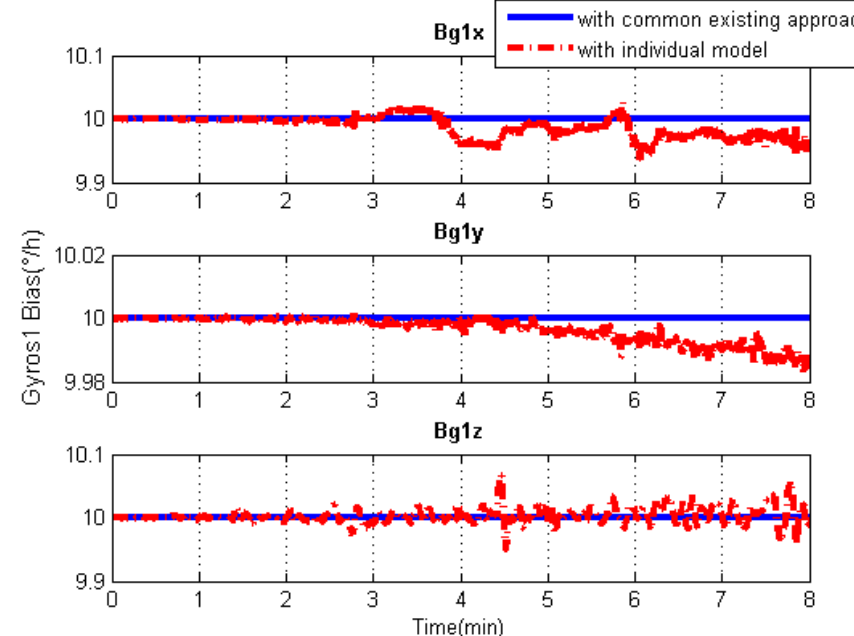
Figure 13. Gyroscope bias solution comparisons of the central IMU using the common existing approach or the individual modeling method.